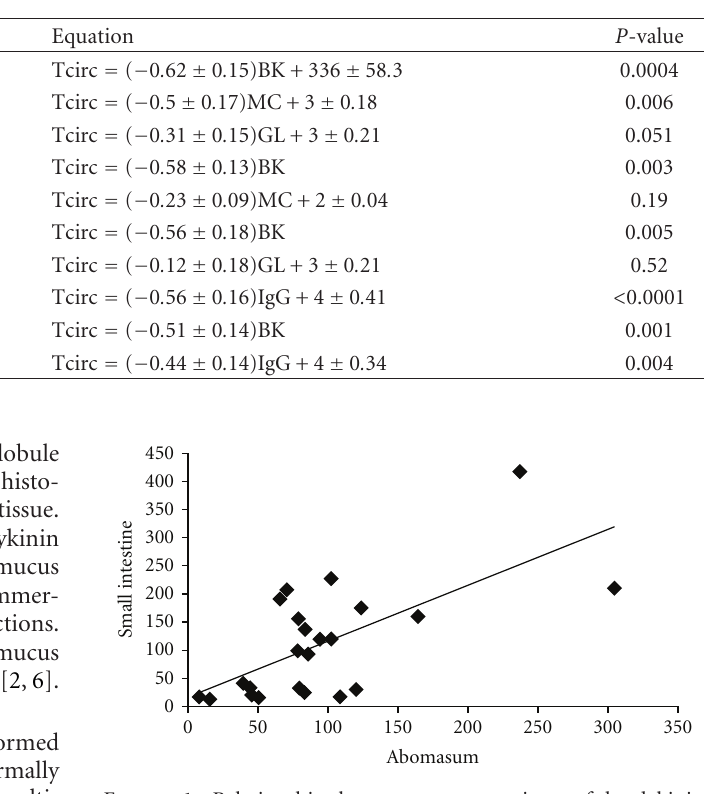
relationship between intestinal bradykinin and numbers of